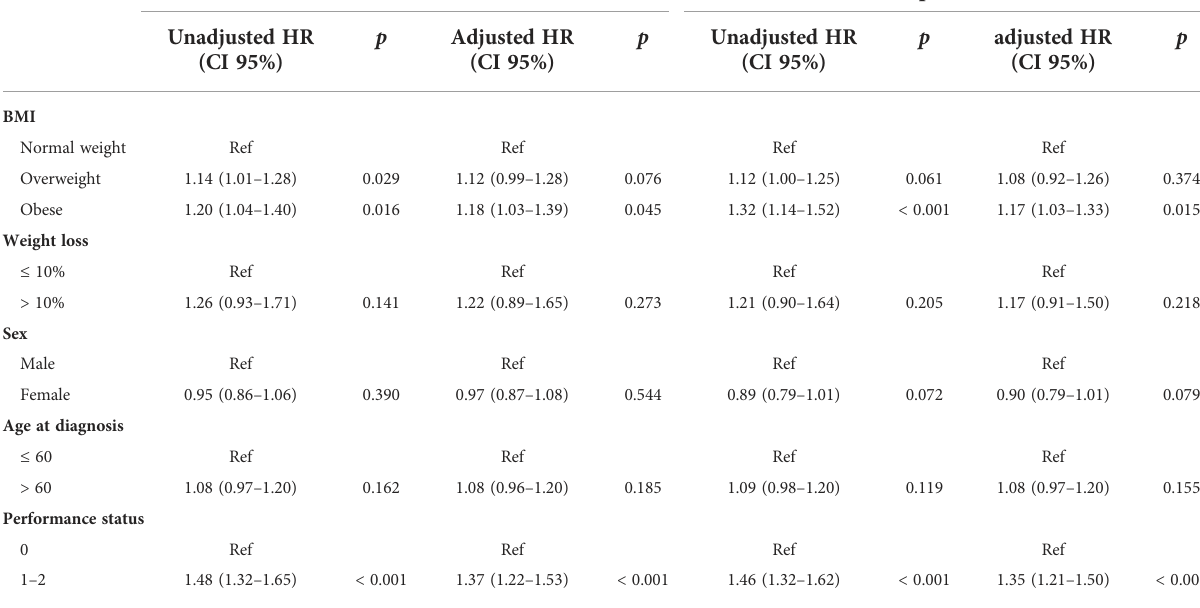
TABLE 2 Associations between BMI and clinical factors with outcome in left-sided